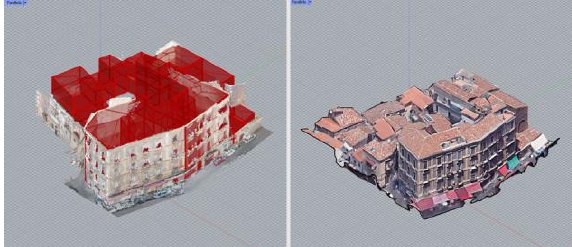
Figure 12 . On the left, SFM point cloud in Grasshopper. On the right: 3D Google Earth mesh of the city block under examination. Model attribution: Google Earth, @2021 Google.